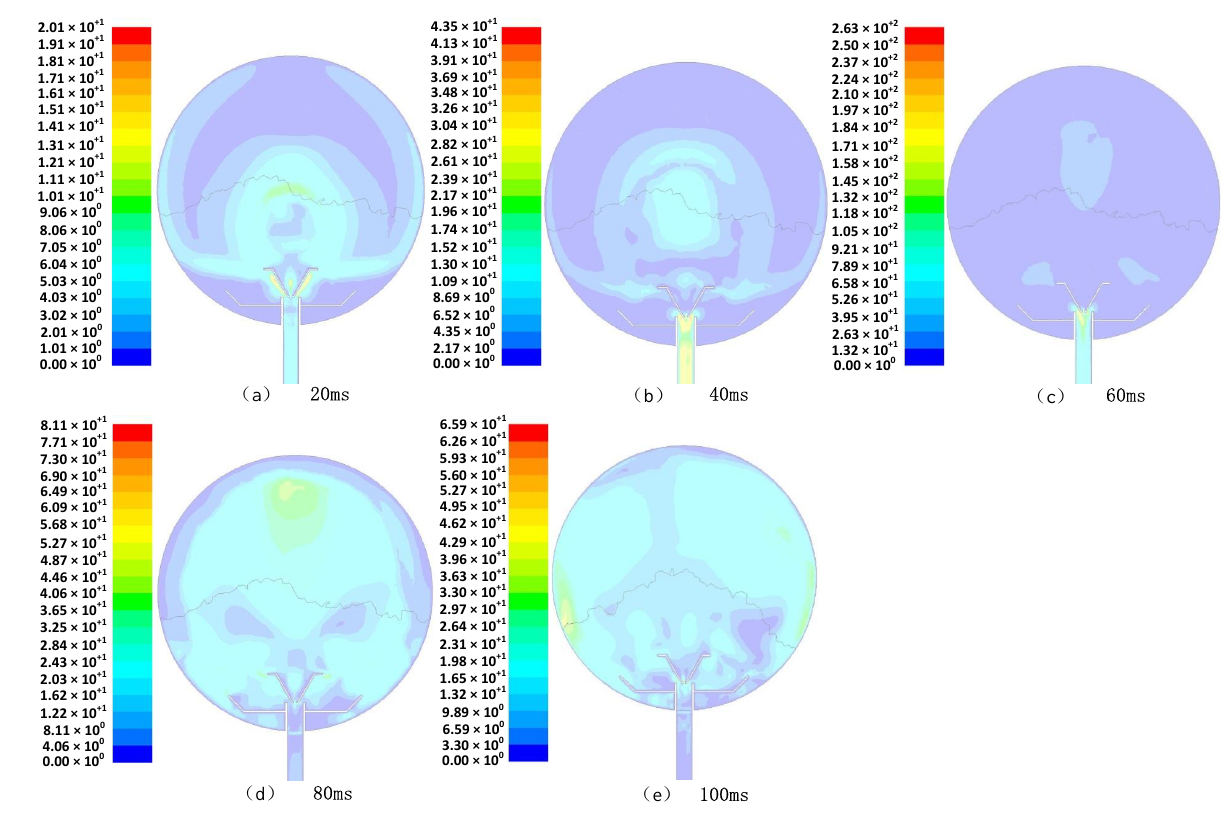
Figure 13. Velocity evolution of flow field.